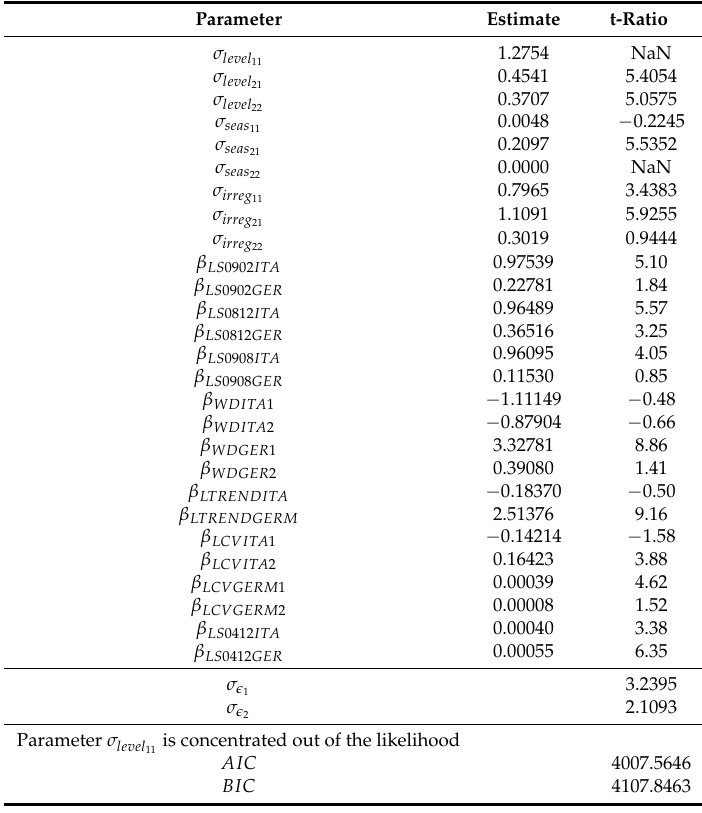
Table A8. Endogenous variables: IPI t intermediate goods TTMI t in Germany.